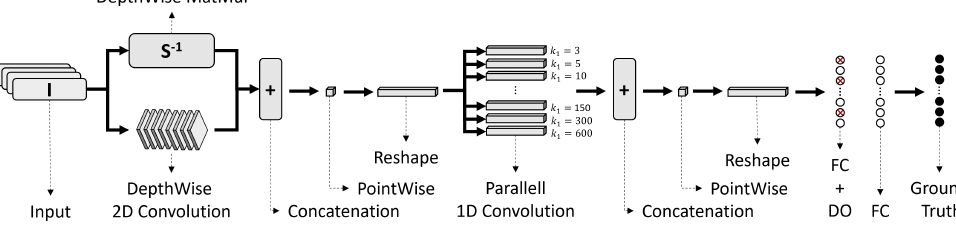
Figure 13. Proposed CNN